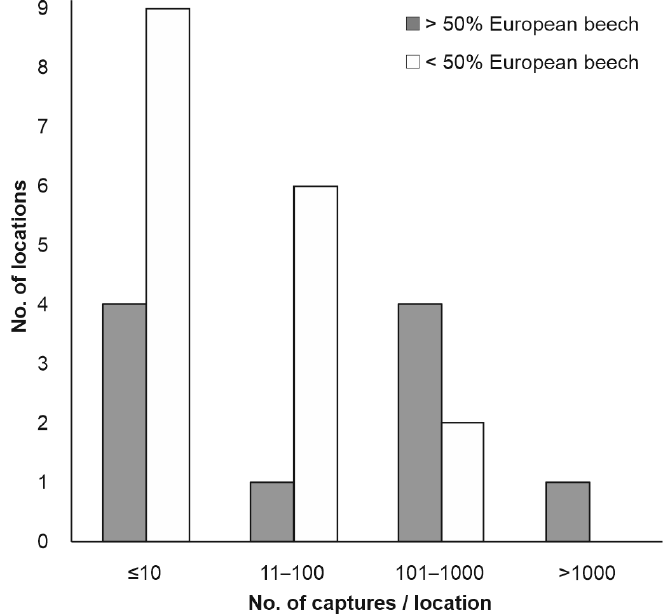
Figure 7. BSB capture variation according to tree stand composition.